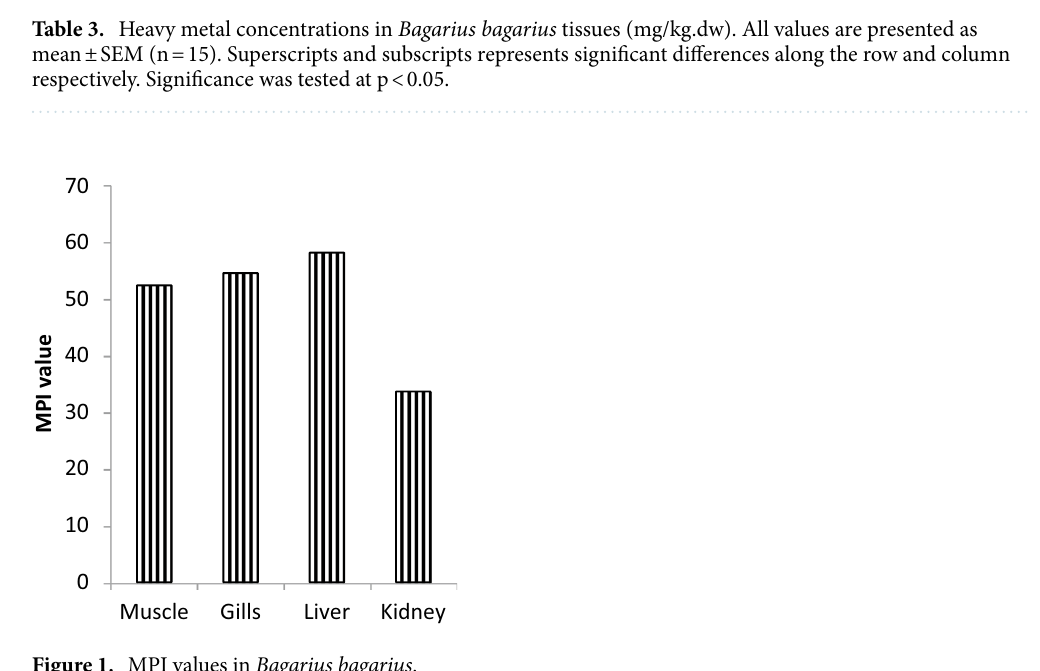
Figure 1. MPI values in Bagarius bagarius .